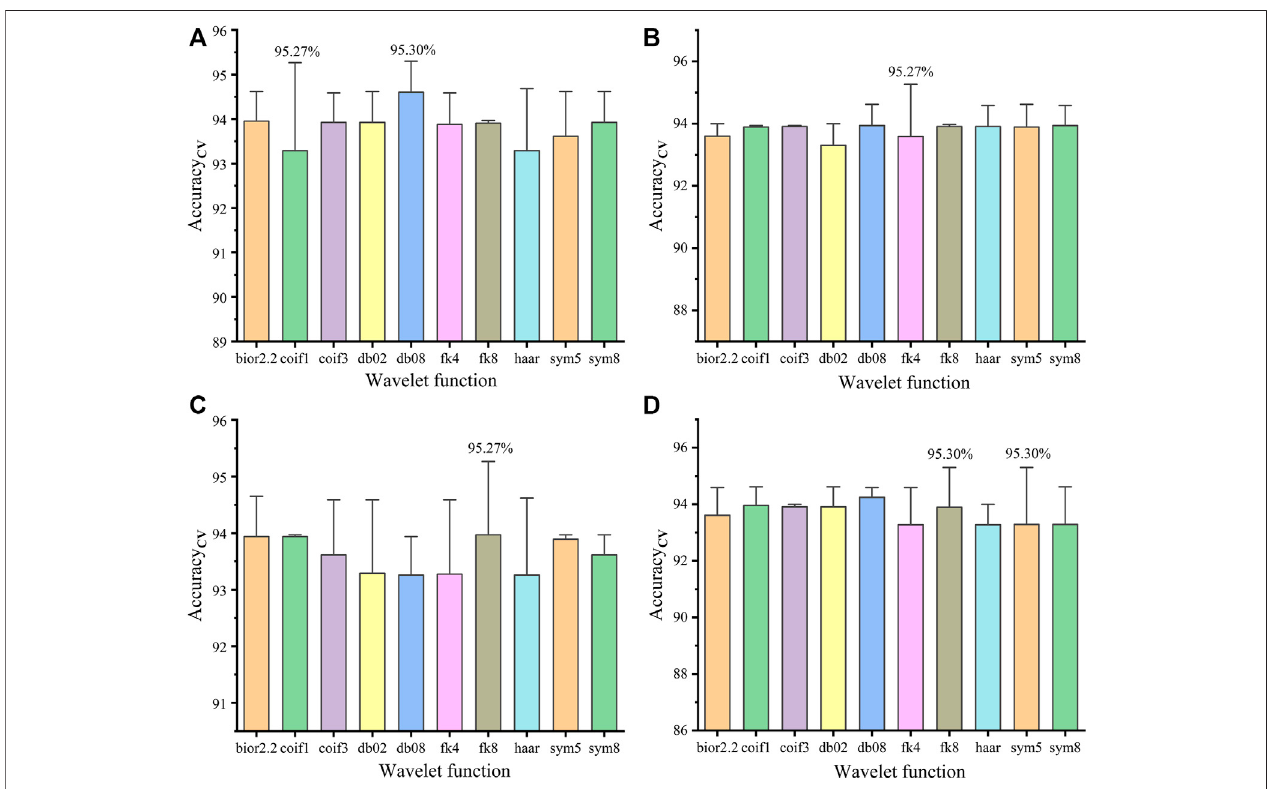
FIGURE 2 | Acc cv ofthe PLS-DA model using FTIR spectral data processed by WTD in four thresholds: heursure (A) , minimaxi (B) , rigrsure (C) , and sqtwolog (D) .